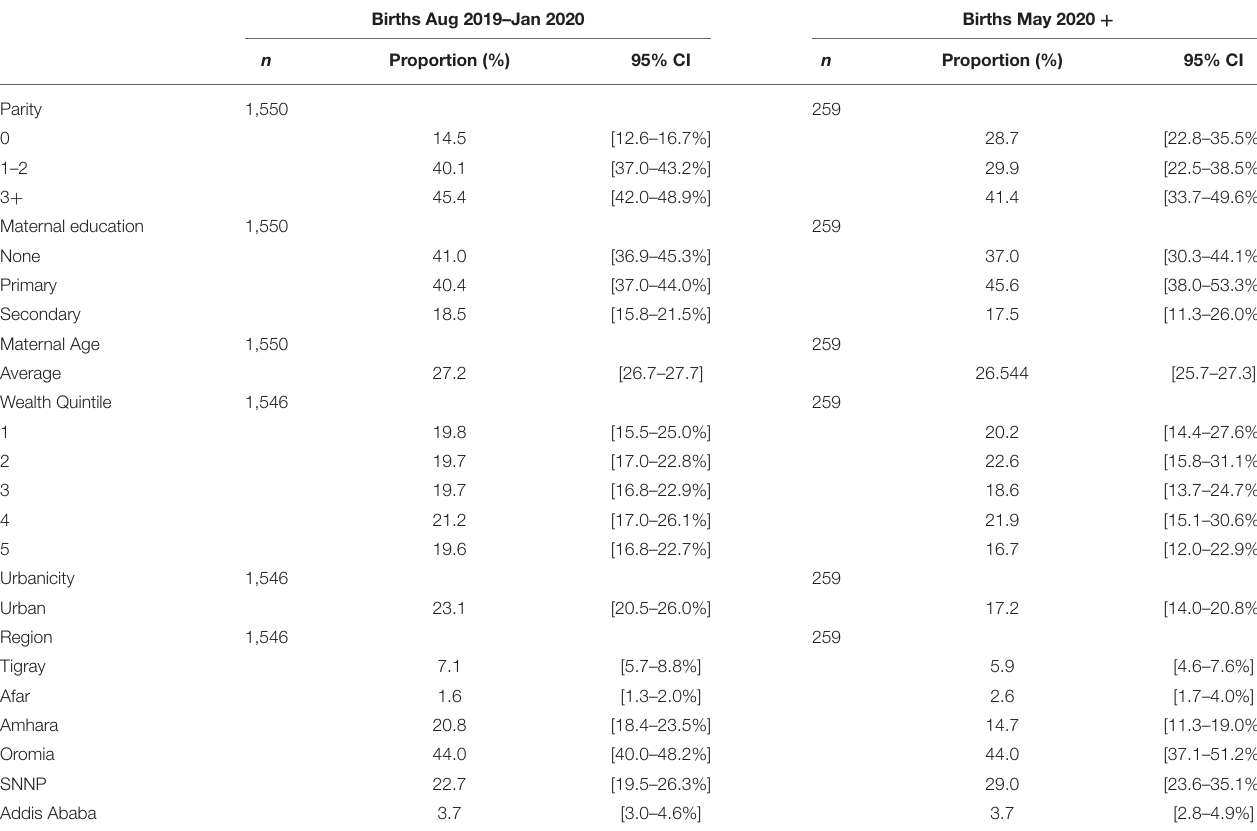
TABLE 1 | Characteristics of